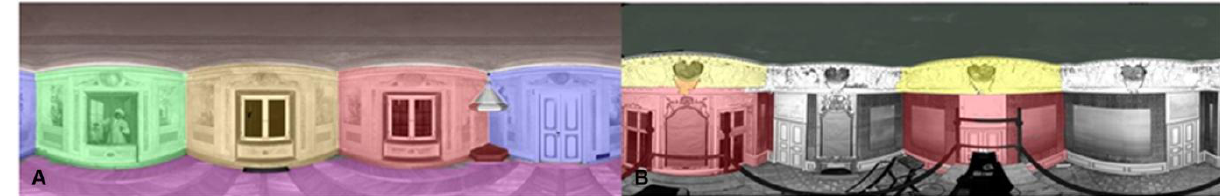
Figure 1. The spherical projection of the point clouds with marked fragments of the used orthoimages: A) Test site I, B) Test site II (Markiewicz, 2017)